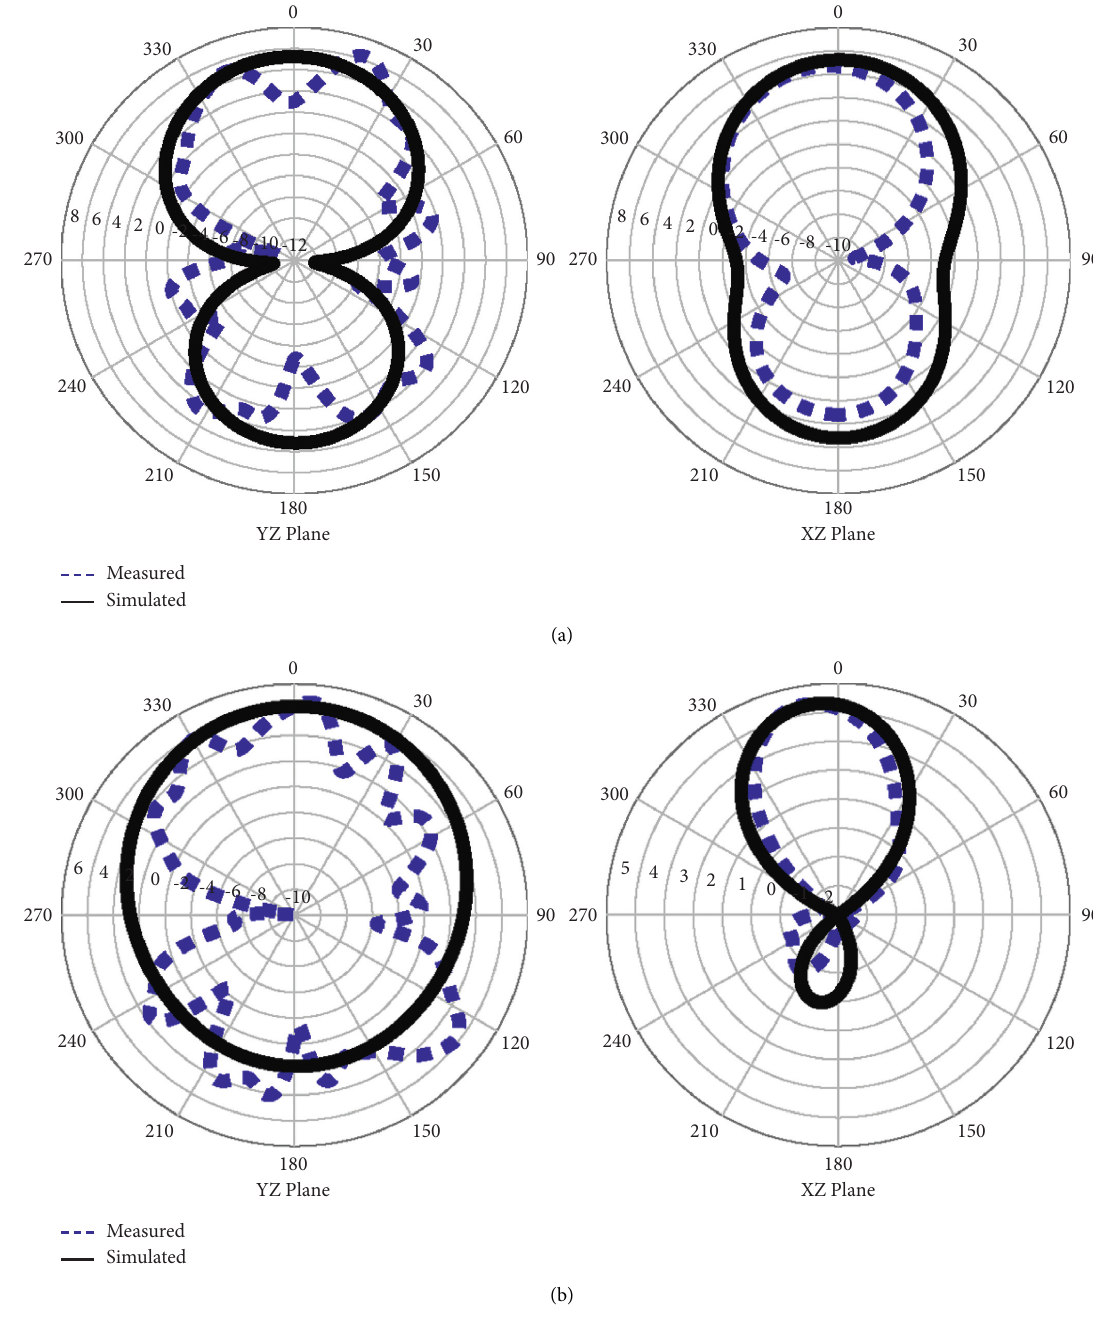
Figure 14: Simulated versus measured radiation patterns at 2.45GHz: (a) case 1 and (b) case 2 (see Table